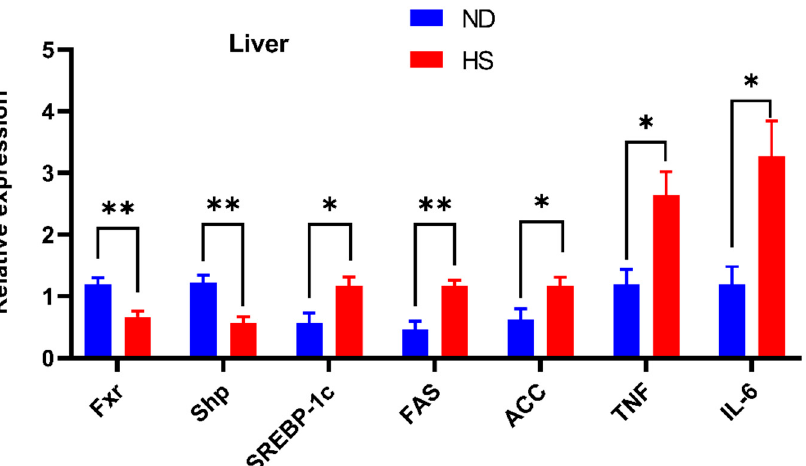
Figure 2. Effect of perinatal high-salt (HS) diet on offspring hepatic mRNA expression associated with farnesoid X receptor (FXR) signaling. Relative mRNA expression of sterol receptor element- binding protein-1c (SREBP-1c), fatty acid synthetase (FAS) , acetyl CoA carboxylase (ACC) , tumor necrosis factor (TNF)- α , and interleukin (IL)-6 in the liver. The expressions were normalized to Gapdh . * p < 0.05; ** p < 0.01. Note: ND, normal diet.